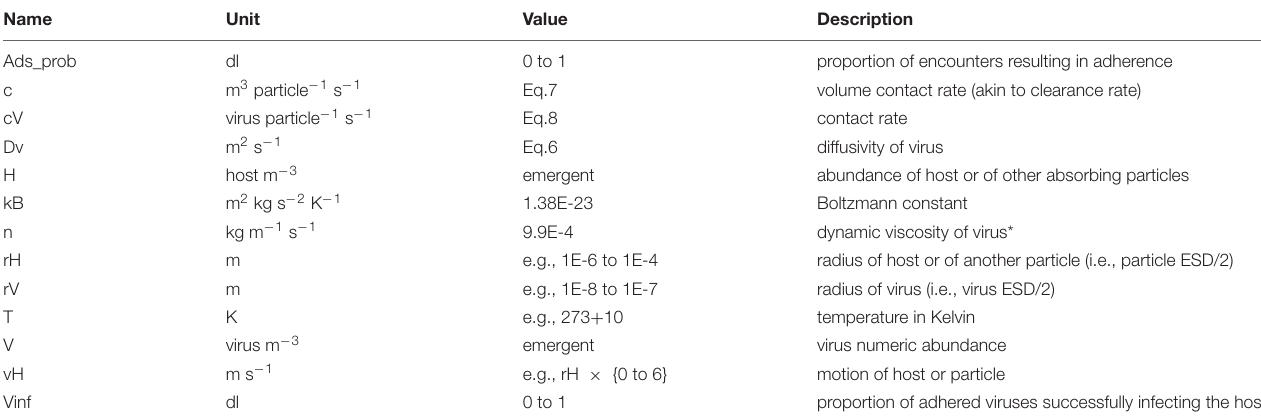
TABLE 1 | Parameters for virus-particle